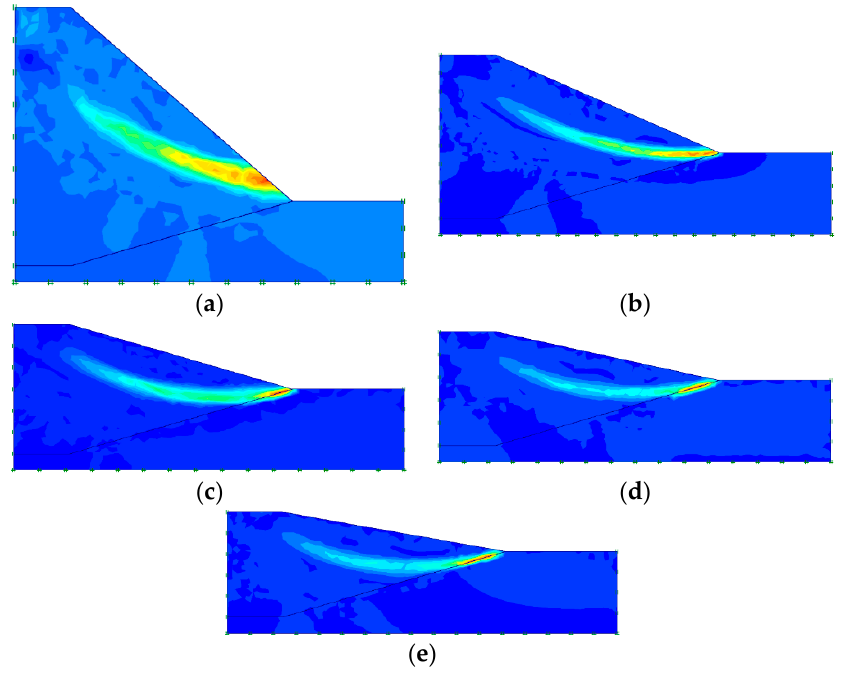
Figure 8. ( a ) 1V/1H; ( b ) 1V/2H; ( c ) 1V/3H; ( d ) 1V/4H; ( e ) 1V/5H. Failure planes (FEM).